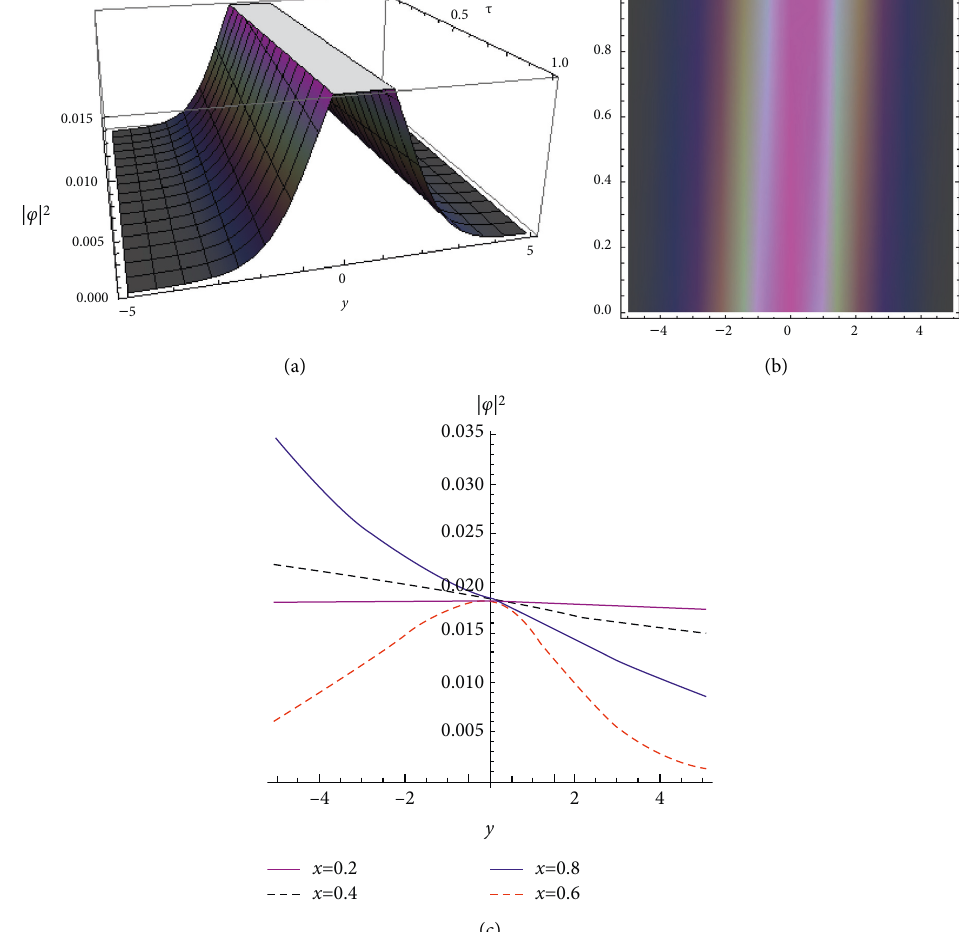
� ς � ω � 1, ς � 0 . 5 � δ , ς � 0 . 4, N � 31, λ � 5, k � 0 . 4, β � 0, and χ � 0 . 2 , 0 . 4 , 0 . 6 , 0 . 8. For the 1 4 2 3